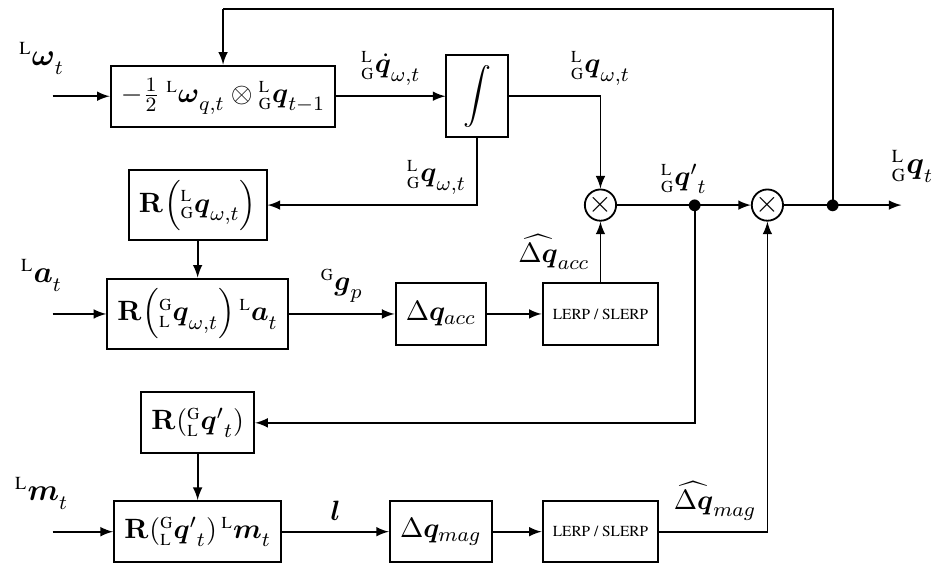
Figure 2. Block diagram of the complementary filter for IMU implementation (no magnetometer data). Figure 3. Block diagram of the complementary filter for MARG implementation (with magnetometer data).